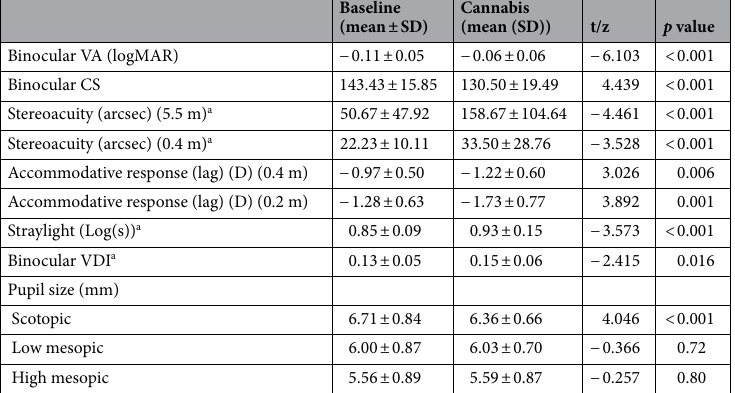
Table 1. Group mean and SD for visual parameters in the two sessions (baseline and after smoking cannabis). VA, visual acuity; CS, contrast sensitivity; VDI, visual disturbance index. a Wilcoxon signed ranks test.